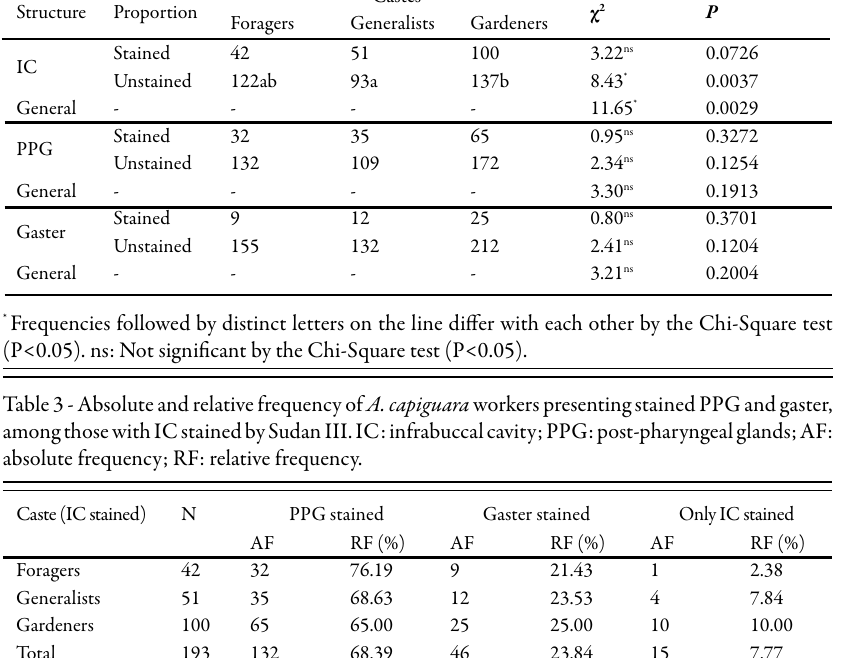
Table 2 - Proportion of A. capiguara workers by caste with anatomical structures stained and unstained after application of baits with Sudan III dye. IC: infrabuccal cavity; PPG: post-pharyngeal glands. Structure